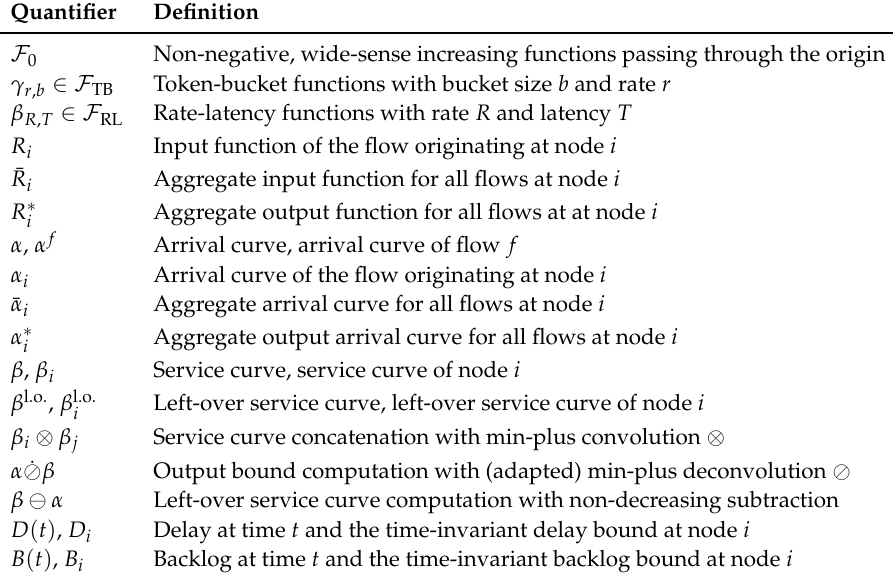
Table 1. Network calculus notation for functions of arrivals and service, as well as their min-plus algebraic manipulation and performance